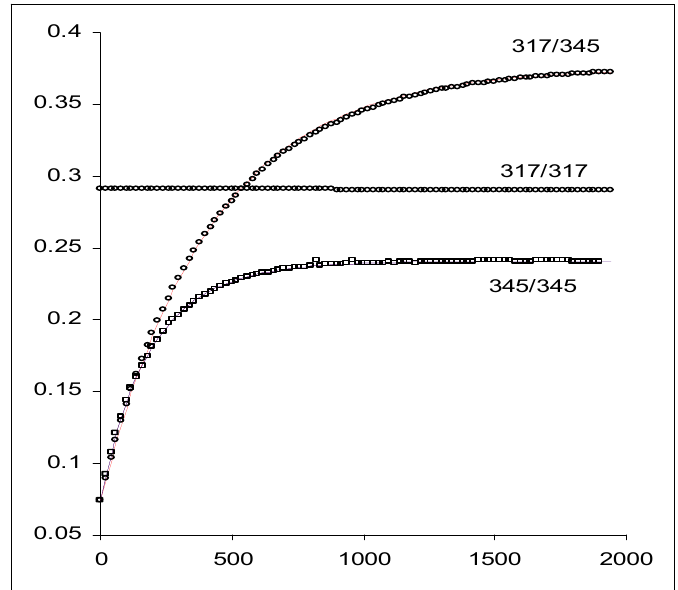
Figure 11 : Experimental traces of DAE (5.6 10 -5 M) in hexane at 15 ° C. The kinetic traces are labelled by the wavelengths at which the irradiation and the observation were carried / λ ). Two of the curves (317/317 and 317/345, in circles) have been performed out ( λ exc obs using the isosbestic irradiation and the third resulted from a non-isosbestic irradiation (345/345, in squares). The line linking the points of trace 317/345 represents the best fit to the monoexponential model, Eq.21a. The line shown on the trace 345/345 has been calculated by a RK integration using the data supplied by the elucidation method (Table 5) [reprinted from Ref. 94 with permission of Photochemical and Photobiological